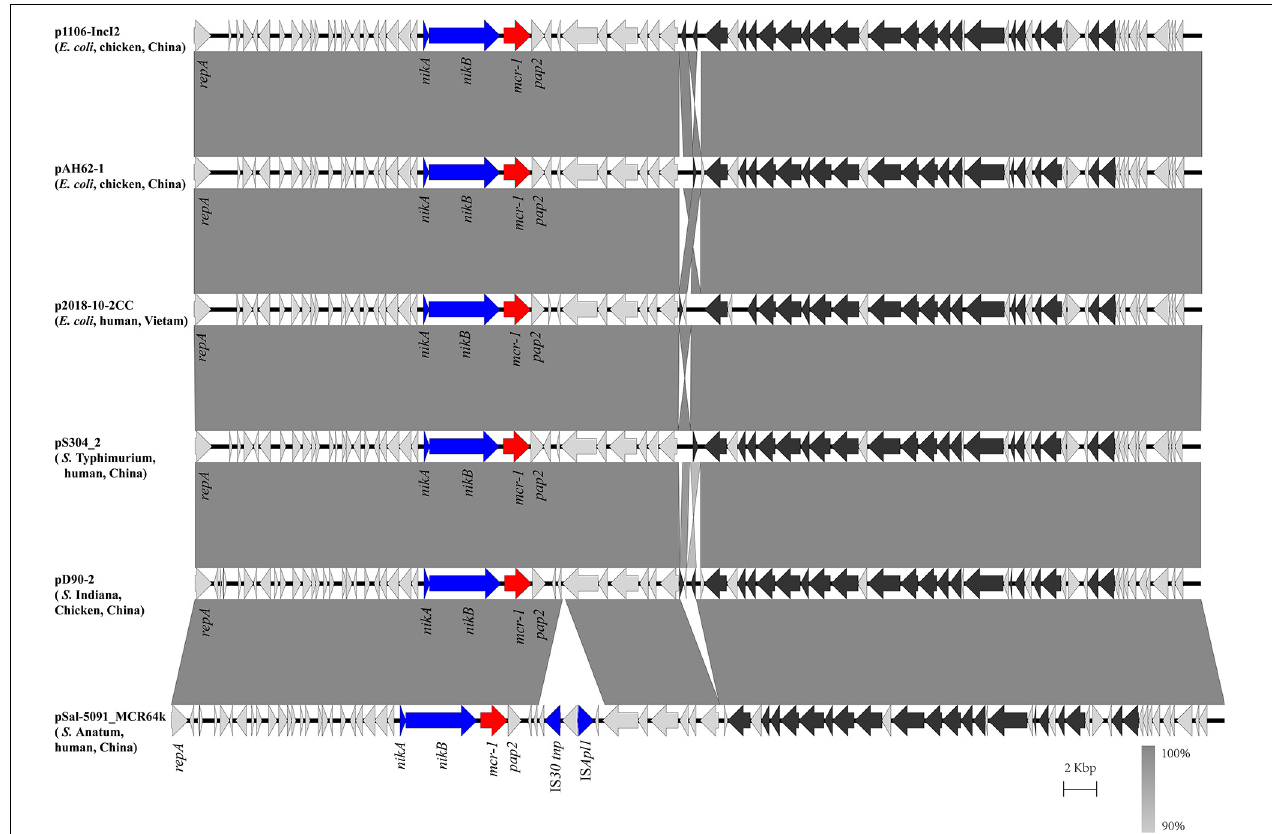
FIGURE 2 | Scaled, linear diagrams comparing the sequences between plasmid pS304_2, p1106-IncI2 (GenBank no. MG825374.1), pAH62-1 (GenBank no. CP055260.1), p2018-10-2CC (GenBank no. LC511622.1), pD90_2 (GenBank no. CP022452.1), and pSal-5091_MCR64k (GenBank no. CP045521.1). Antibiotic resistance genes are indicated in red arrows. The individual conjugation-related genes are indicated with black arrows. Blue arrows denote transposon- and integron-associated genes. Other genes are shown as gray arrows.